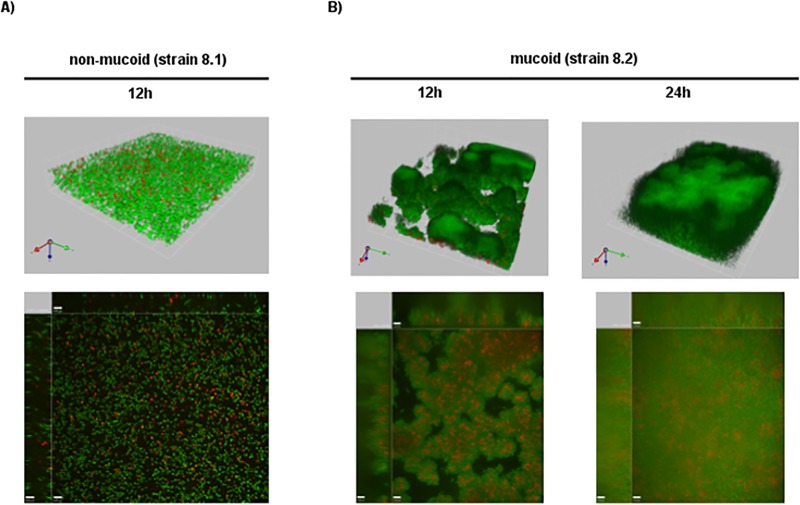
Confocal microscopy of biofilms of the non-mucoid (strain 8.1) and mucoid S. aureus (strain 8.2) phenotypes.Adherent bacteria were stained using the LIVE/DEAD BacLight kit. A). The green color indicates live and the red color dead cells. Only scant amounts of biofilm were detected for non-mucoid isolates. The average biofilm thickness was low (<10 μM at 24h). B) The mucoid strain produced a stable biofilm, which revealed the typical mushroom-shaped multicellular structure. The average height of the biofilm produced by the mucoid strain was 23 μM after 24 h.